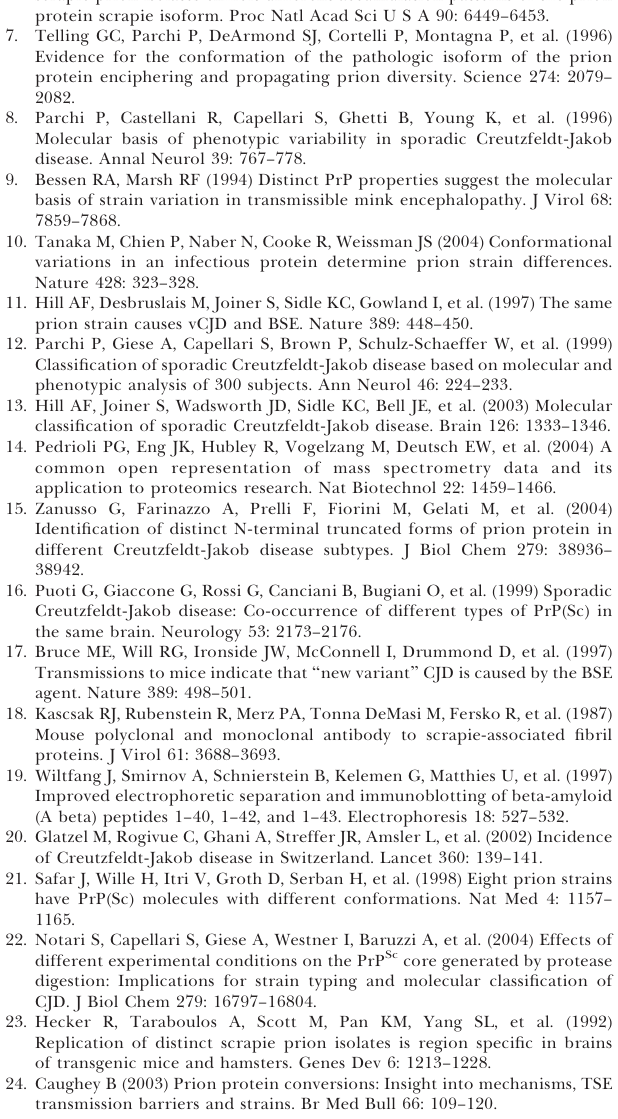
Table S1. Histological Assessment of the VV2 Subgroup of Patients Cases 1 to 4: spongiosis is scored on a scale from 0–4; astrogliosis and PrP immunoreactivity are scored on a scale from 0–3. Found at DOI: 10.1371/journal.pmed.0030014.st001 (41 KB